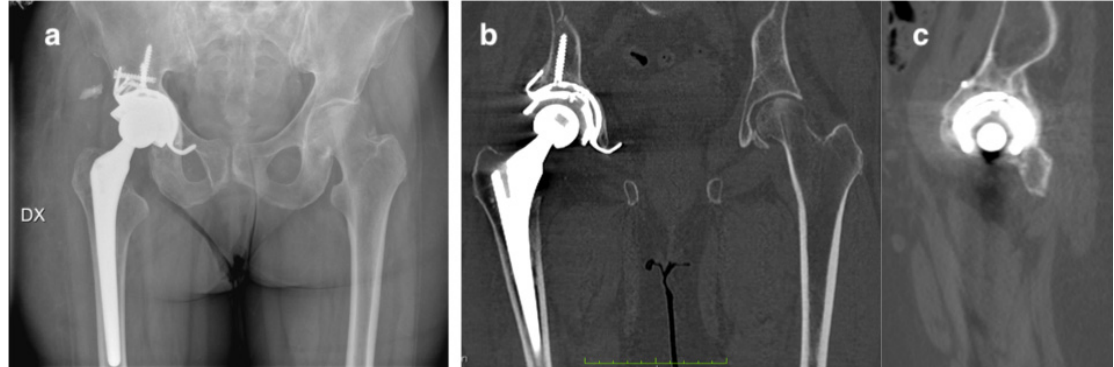
Figure 5. ( a ) Postoperative AP radiograph of the pelvis and ( b,c ) CT scan of the pelvis at 3 months after the surgery shows the good implant positioning and the complete fracture healing with abundant callus formation.